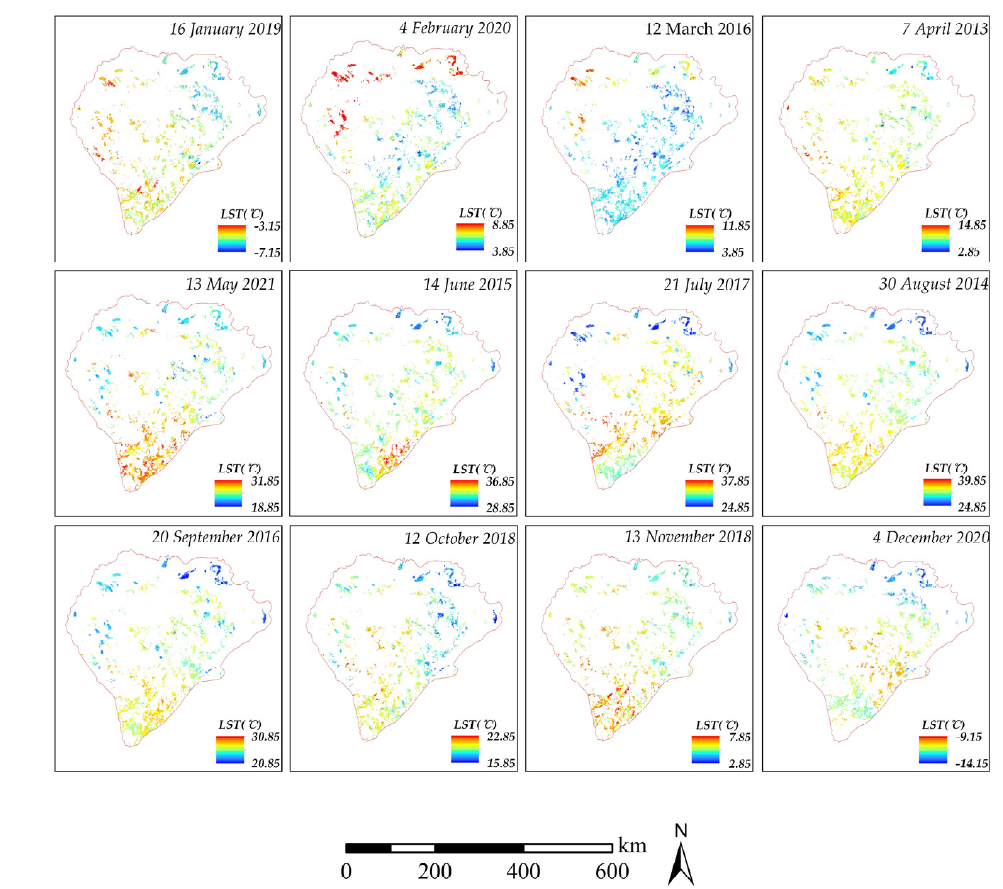
Figure 4. Spatial distribution of surface temperature in saline–alkali land and paddy fields in Da’an City, western Jilin Province.